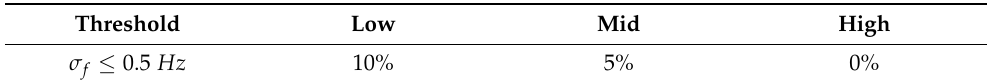
Table 3. Total of coherent reflections below the Doppler spread threshold at low, mid, and high eleva- tion.